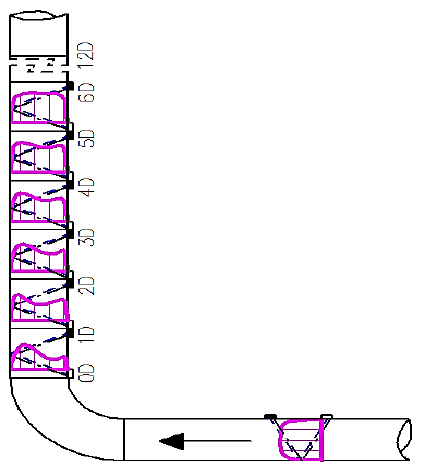
Figure 4. Diagram of the distribution of measuring cross-sections in a flow system.